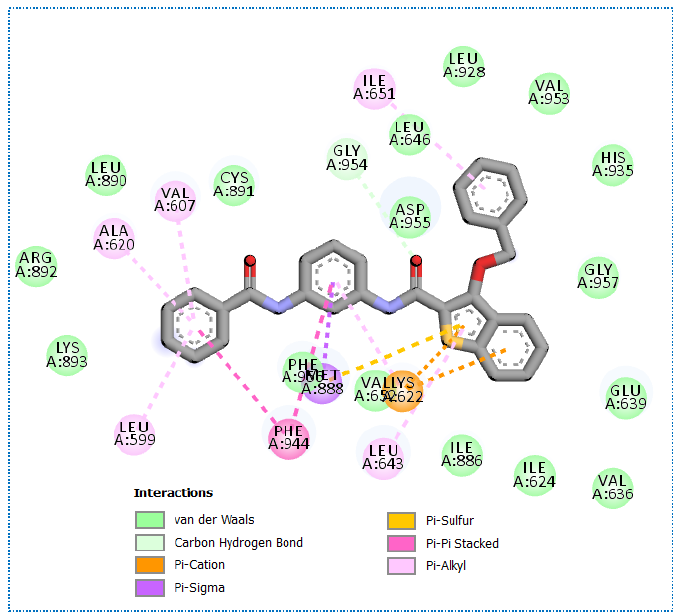
Figure 13. The 2D binding of compound 35 with Eukaryotic translation initiation factor 2-alpha ki- nase 3 (PDB ID: 4 × 7 h).